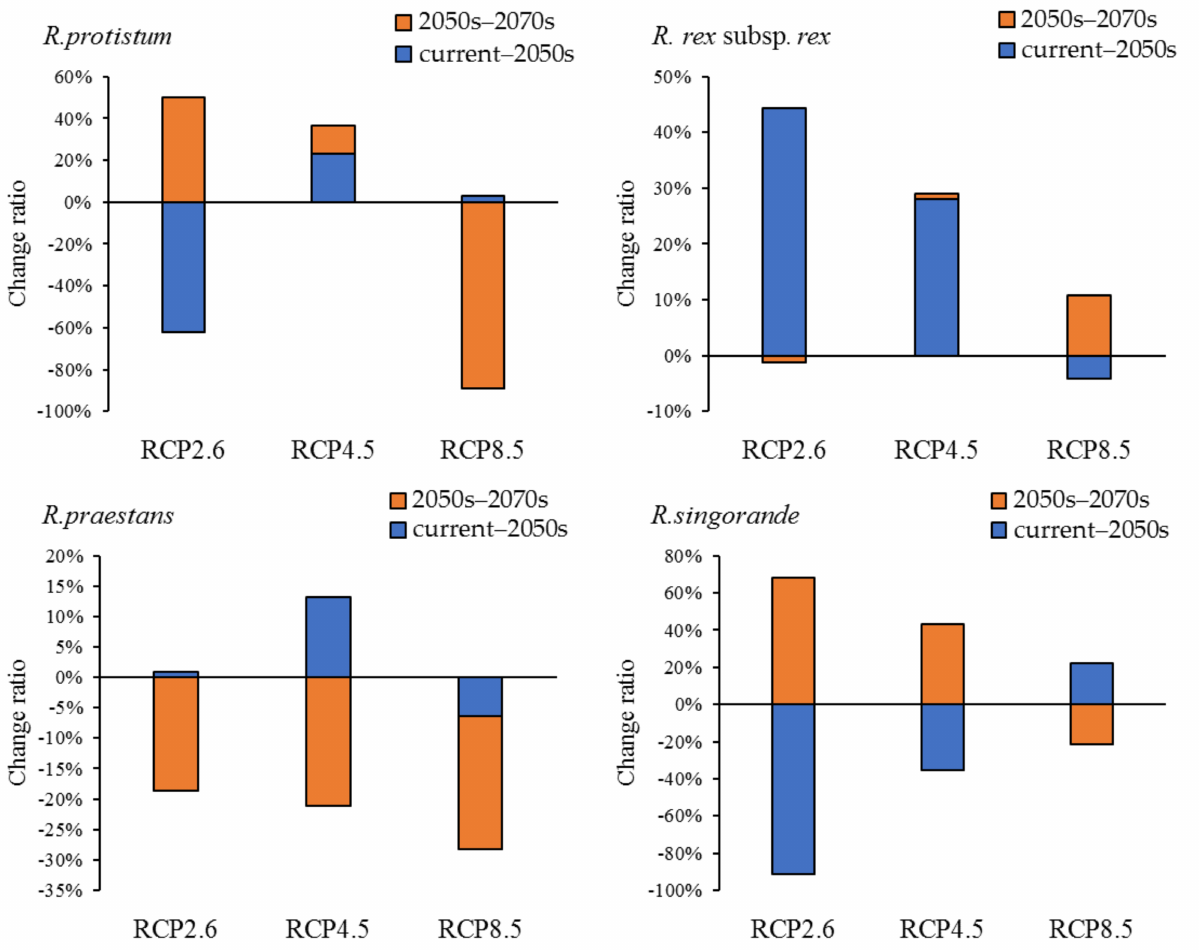
Figure 5. Change ratio of high-suitability habitat distribution range for four Rhododendron species in two periods (current- 2050s and 2050s–2070s) under RCP 2.6, RCP 4.5, and RCP